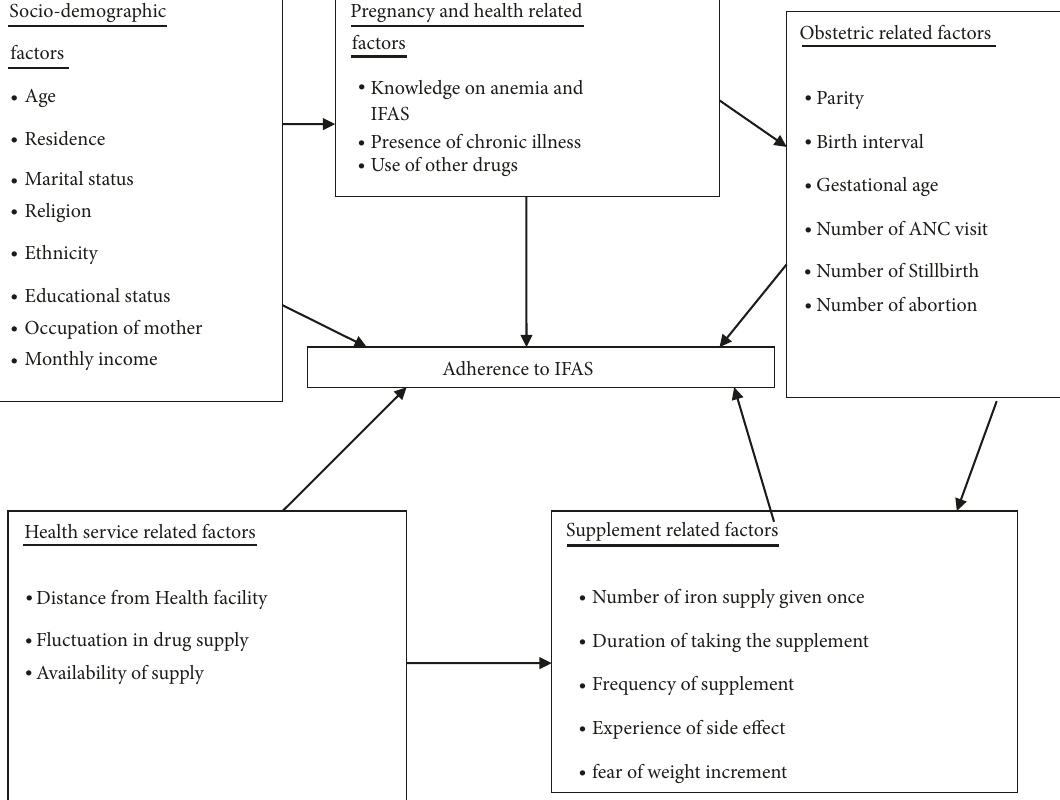
Figure 1: Conceptual framework adapted from different literature review [21, 24,